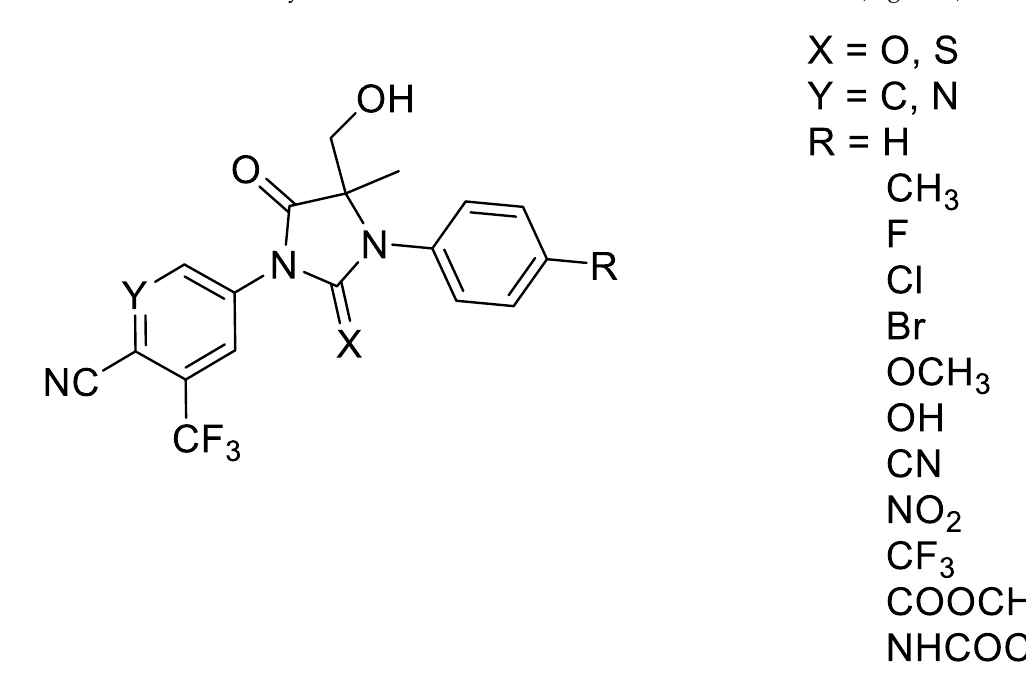
Figure 1. Structures of known AR antagonists.